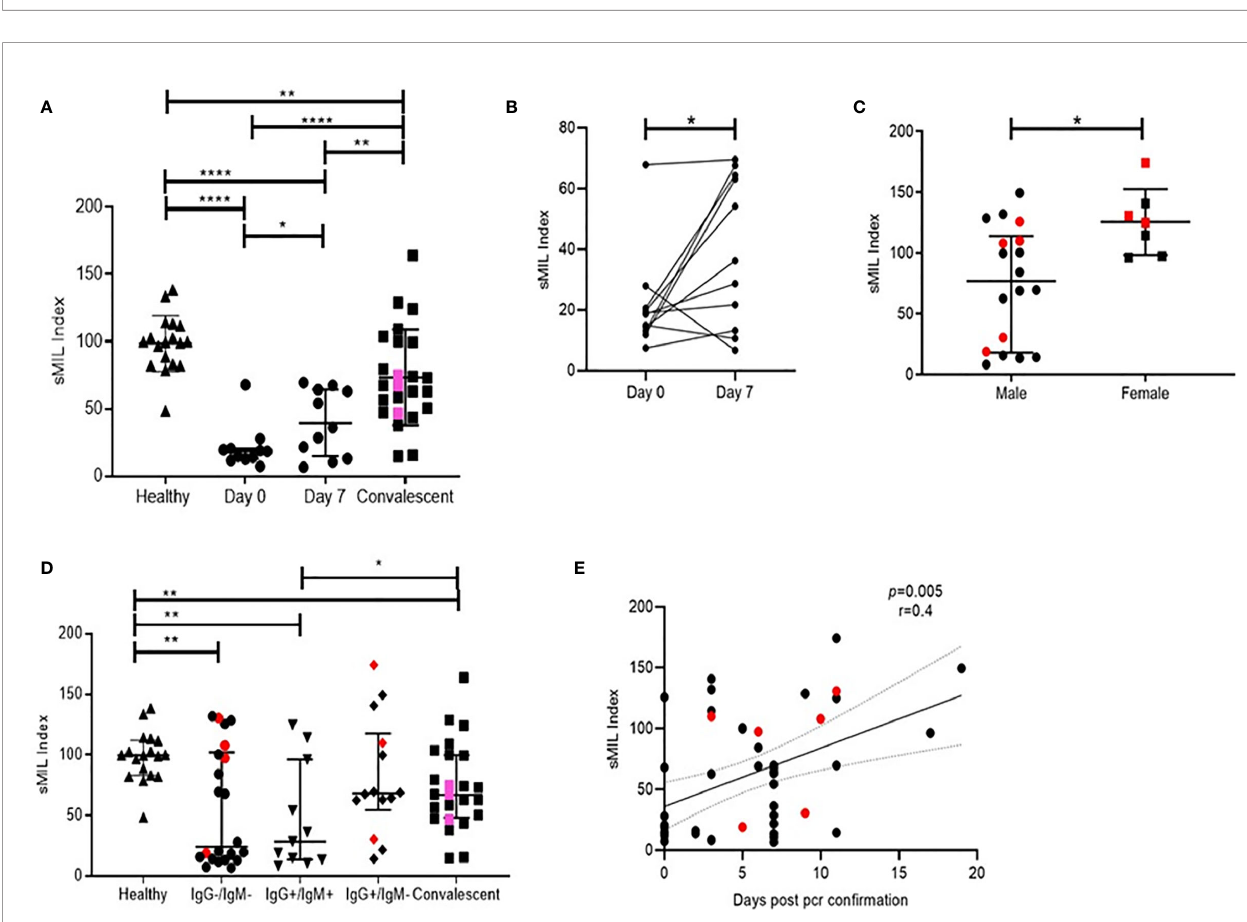
FIGURE 3 | Distribution of peak RU across various groups of study participants. Also the resolution of fi gures are satisfactory (A) Variation in sMIL index at day 0 (n = 11), day 7 (n = 11), in convalescent (n = 22), and in healthy (n = 16) groups. Pink colored symbols indicate IgG − /IgM − individuals in convalescent group. (B) Change in sMIL index between day 0 (n = 11) and day 7 (n = 11) expressed per individual. (C) Differences in sMIL index between male (n = 18) and female (n = 7). (D) Comparison of sMIL index between healthy (n = 16), IgG − /IgM − (n = 22), IgG+/IgM+ (n = 11), IgG+/IgM − (n = 14), and convalescent (n = 22) groups. (E) Association of sMIL index with days since SARS-CoV-2 con fi rmation by PCR (n = 47). Red colored symbols represent asymptomatic individuals. Statistical analysis was performed using Graphpad Prism 8.0. Wilcoxon matched-pairs signed rank test was used to compare paired samples of day 0 and day 7. Mann – Whitney U-test was used to compare unpaired groups. *p < 0.05, **p < 0.01 and ****p < 0.001. Correlation analysis was performed using non-parametric Spearman rank correlation